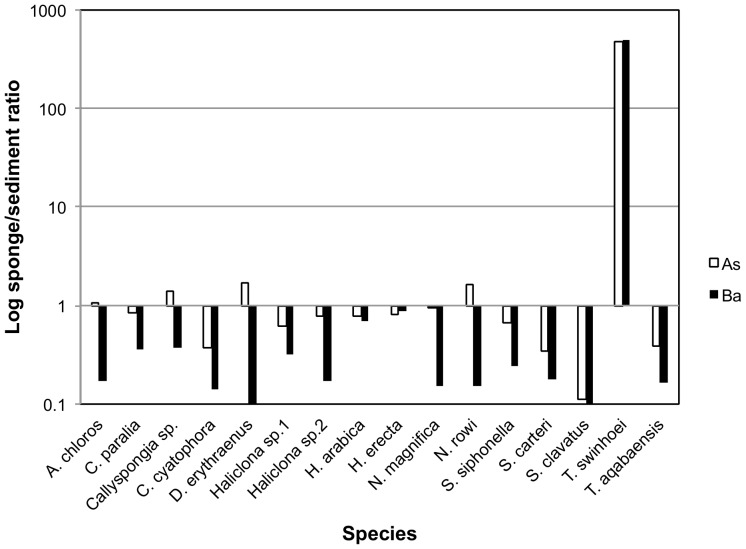
Bioconcentration factors of As (white) and Ba (black) in all sponge species compared to sediment (value set as 1).